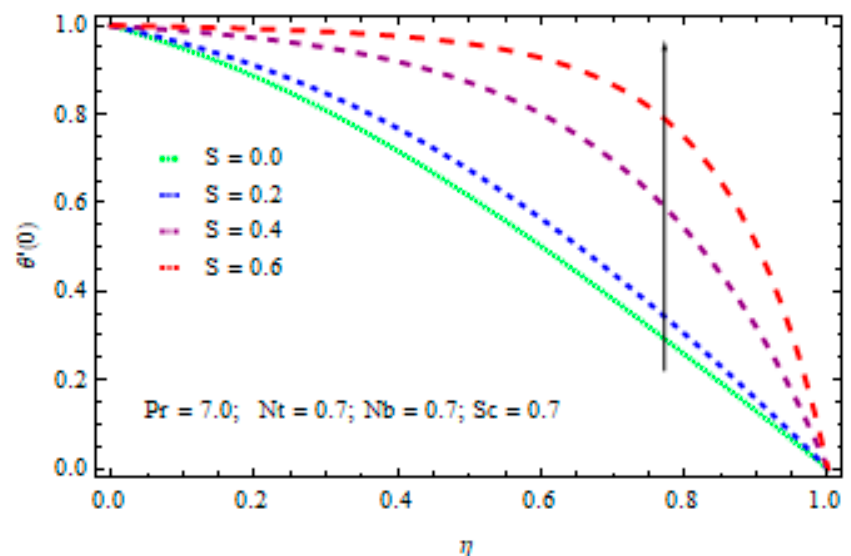
Figure 14. The impact of the unsteady parameter S on the concentration.